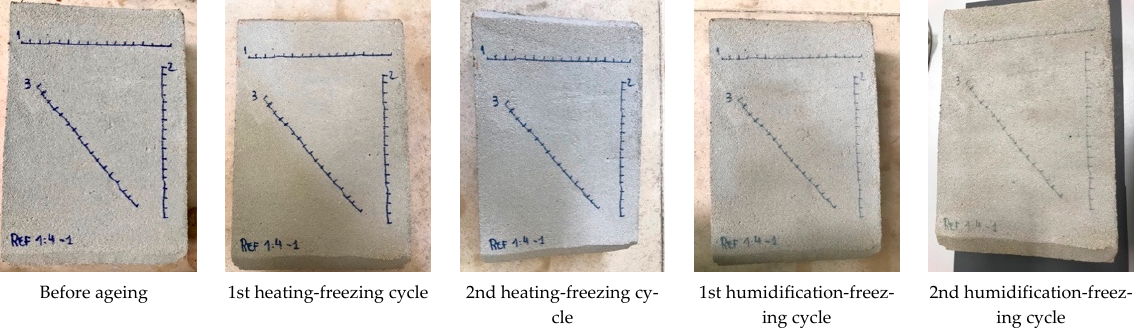
Figure 13. Visual aspect of the reference cement mortar during the artificial ageing test.